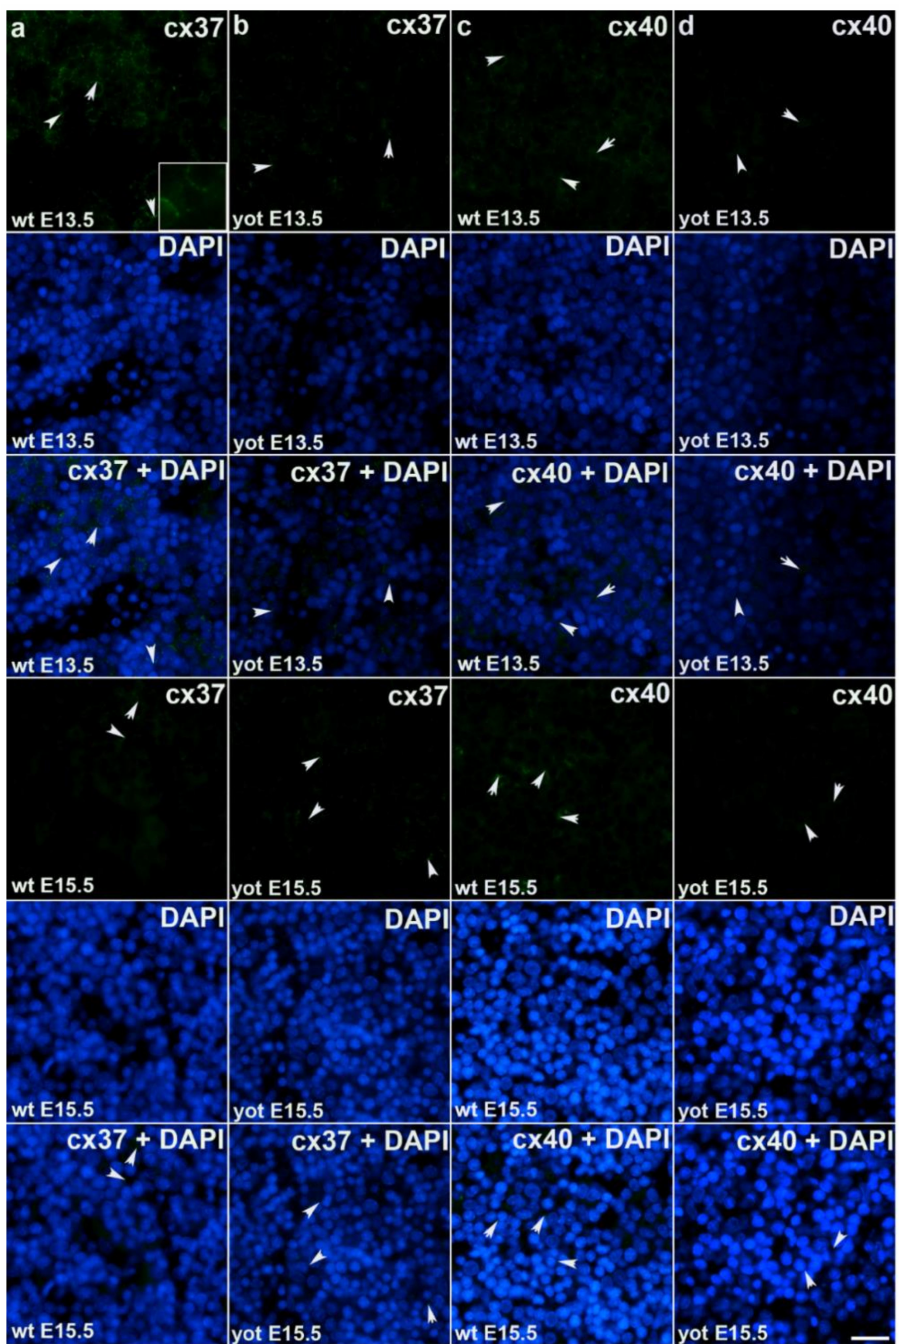
Figure 3. Immunofluorescence staining of connexins (Cxs): Cx37 and Cx40 in wild type and yotari mouse liver at gestation days E13.5 and E15.5. Immunoexpression of Cx37, 4 (cid:48) ,6-diamidino-2- phenylindole dihydrochloride (DAPI) staining and merged Cx37 and DAPI at E13.5 and E15.5 in wild type ( a ) and yotari ( b ). Immunoexpression of Cx40, DAPI staining and merged Cx40 and DAPI at E13.5 and E15.5 in wild type ( c ) and yotari ( d ). The scale bar is 8 µ m, refers to all